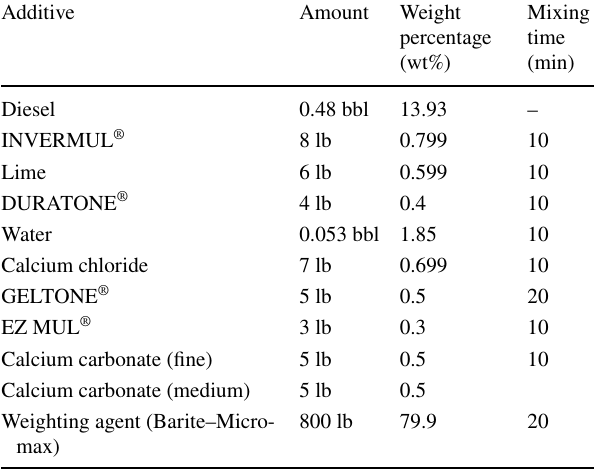
Table 1 Drilling fluid recipe in field units (1 bbl of mud)